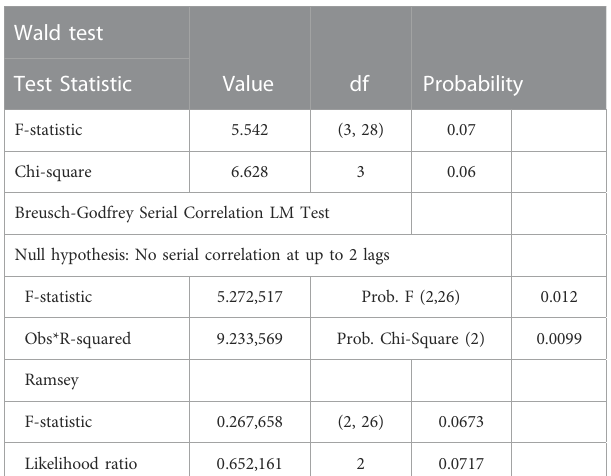
TABLE 5 Diagnostic test.